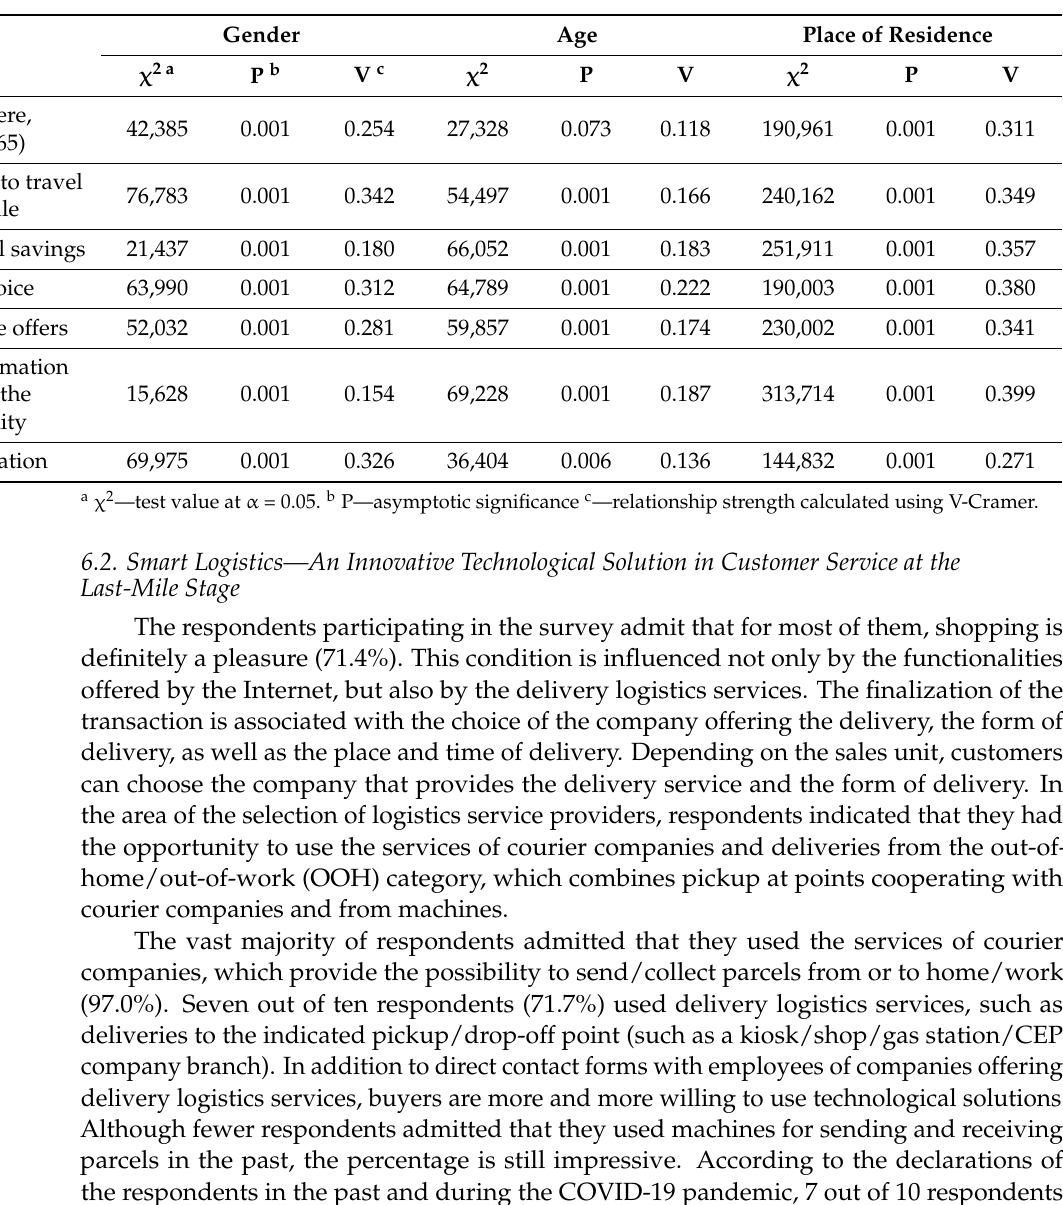
Table 3. Advantages of the Internet as a shopping destination in terms of gender, age, and place of residence as represented through the results of a χ 2 independence test with relationship strength determined by